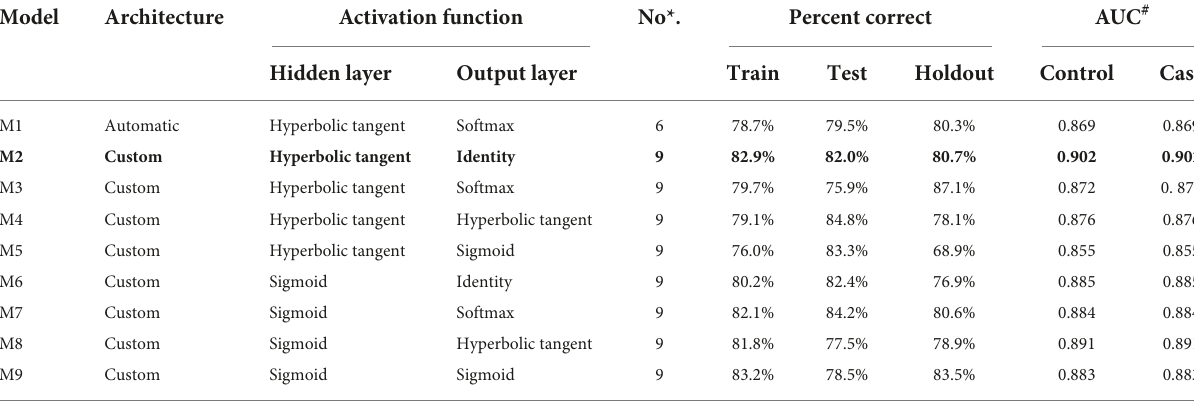
TABLE 6 The multilayer perceptron models of suicide and the evaluation